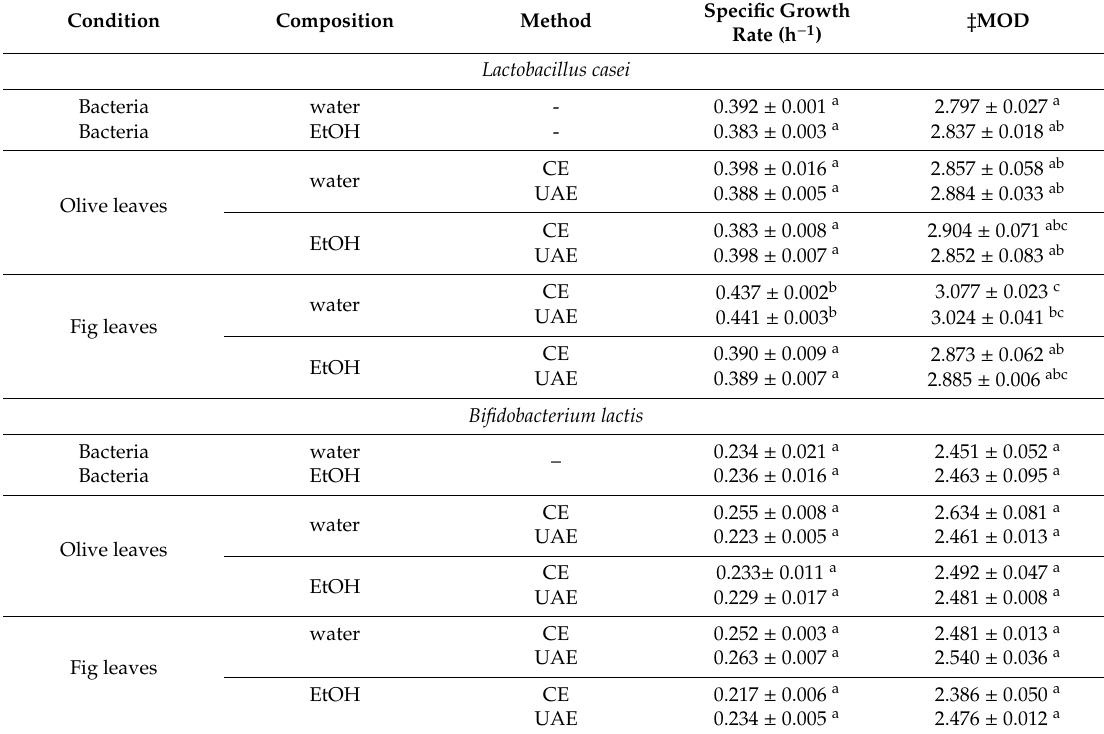
Table 4. E ff ect of olive and fig leaves extracts in the growth rate and maximal optical density of probiotic bacteria